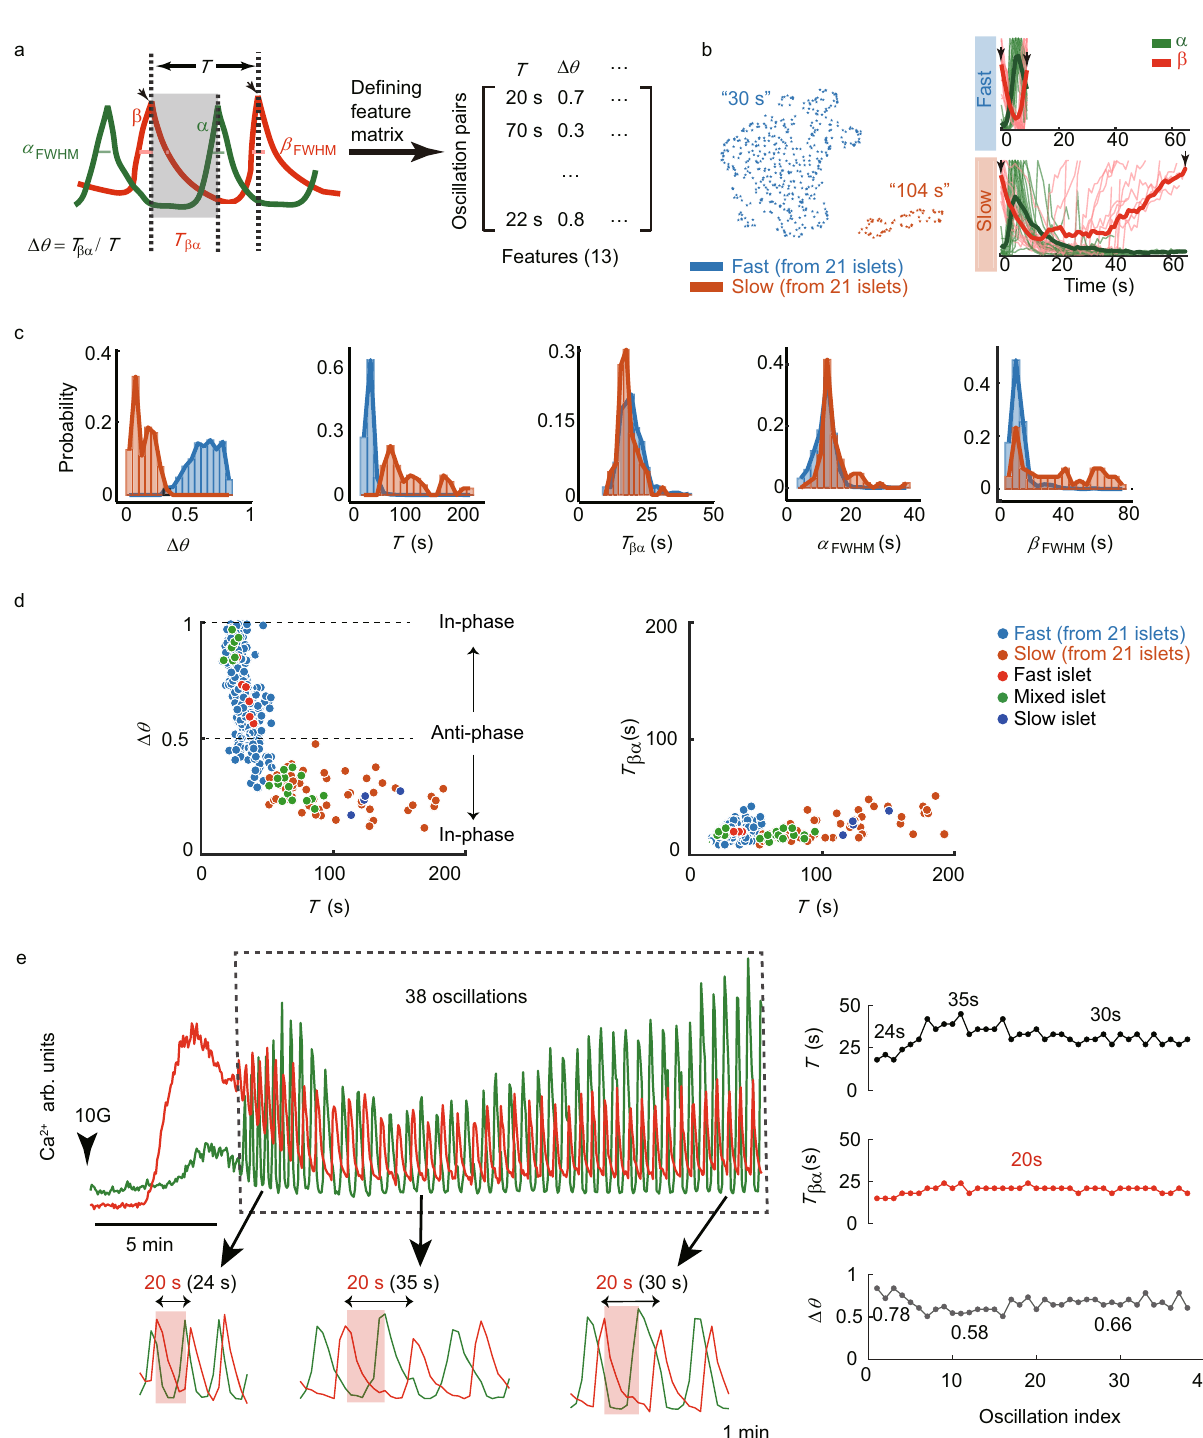
differentiating various Ca 2 + oscillation patterns, we quantitatively de fi ned features of each oscillation cycle of alternately activated α and β cells (Fig. 4a and Supplementary Fig. 3). The oscillation period T was de fi ned as the time window between one cycle of β cell activation. The waiting time for α cell to activate after β cell activation was de fi ned as T βα . The phase difference ( Δ θ ) of two types of cells was de fi ned as the ratio between T βα and T . There were multiple ways to determine these quantities — either using the peak, 25%, 50%, or 75% decrease — and they did not change the outcome of the analysis (Supplementary Fig. 4b – d). In total,